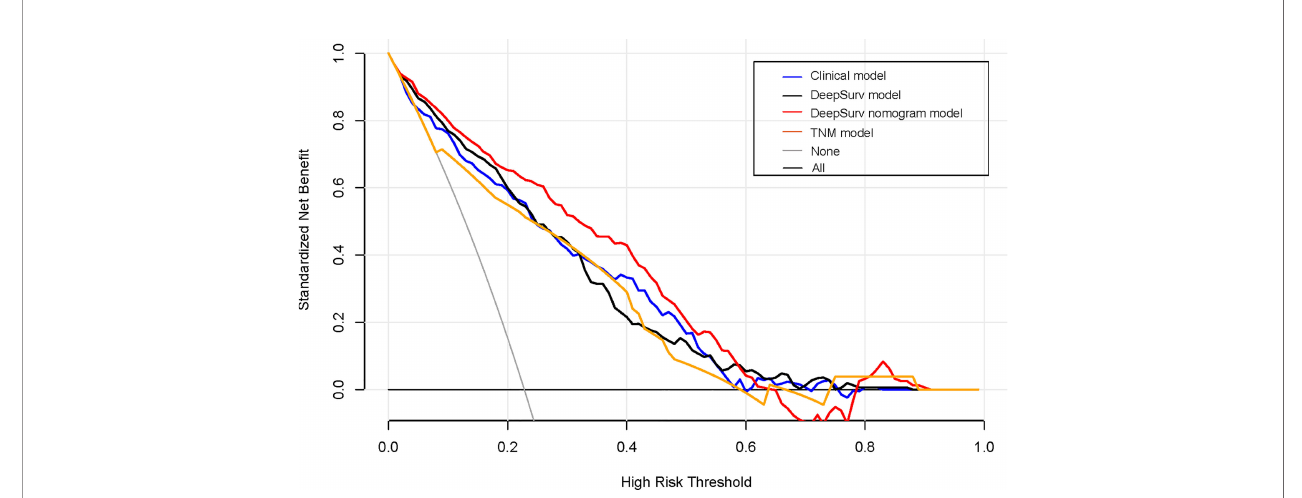
FIGURE 7 | Decision curve analysis for each model. The y-axis measures the net bene fi t, which was calculated using true-positive and false-positive results. The clinical plus DeepSurv model had the highest net bene fi t at a threshold of 0.1 to 0.9 among all positive (line labeled “ All ” ) and negative predictions (line labeled “ None ” ), compared to the three other models (line labeled “ clinical model, deep learning model, and TNM model ” ).